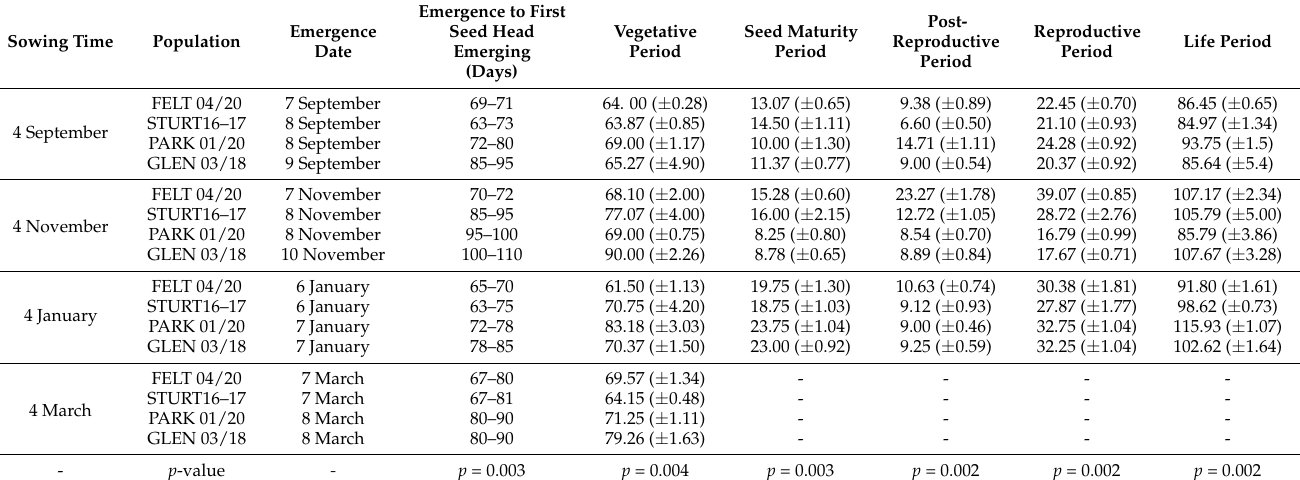
Table 4. Phenological traits and duration of developmental periods (days) of four populations of feathertop Rhodes grass emerged at different times (environmental condition).